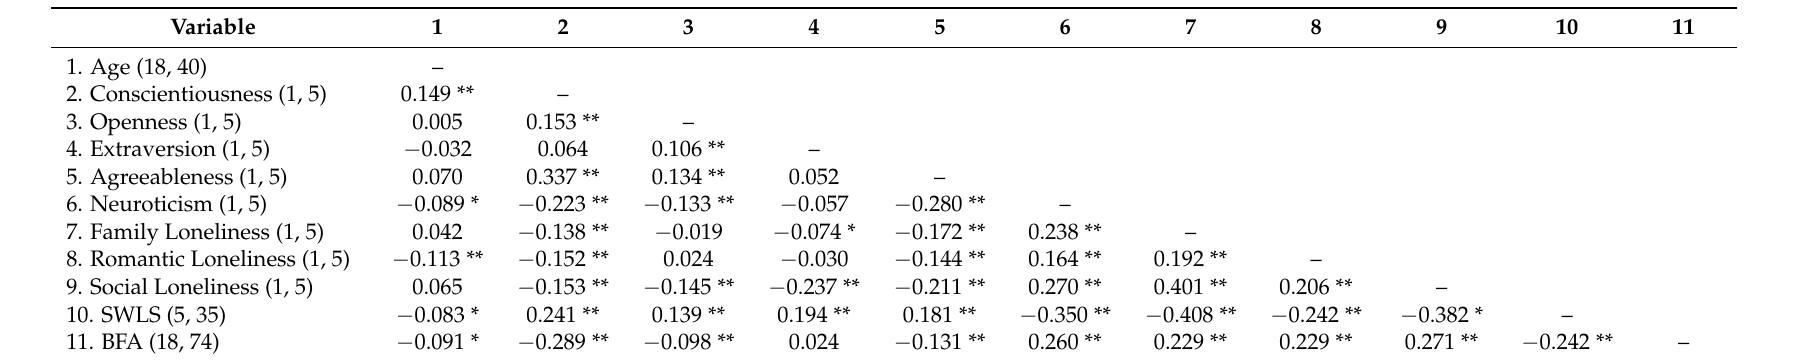
Table 3. Pearson Correlation coefficients among all the